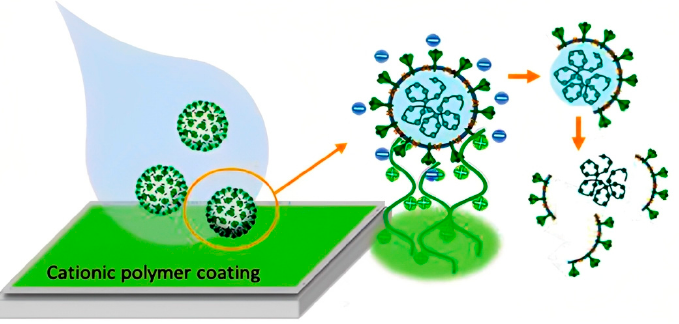
Figure 6. Schematic demonstration of the antiviral mechanism of a cationic polymer (adapted with permission from Mouritz et al. [60]).